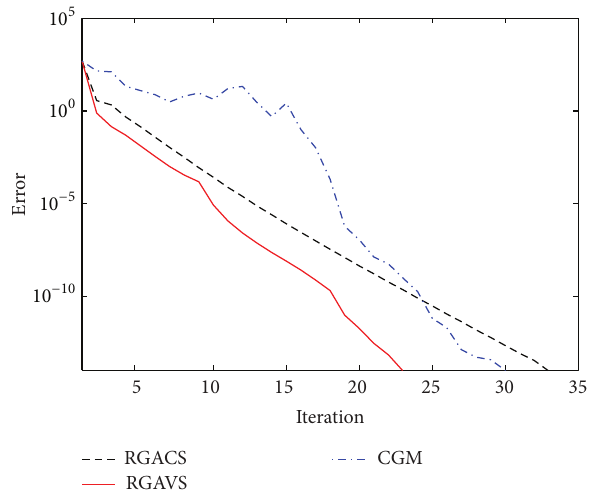
Figure 2: Comparison of convergence speeds (log